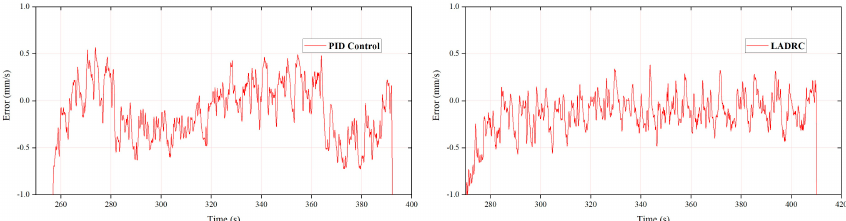
Figure 18. Speed error of cylinder #1 during folding. Table 3. Assessment indices of cylinder#1 motion control using PID and FLADRC.